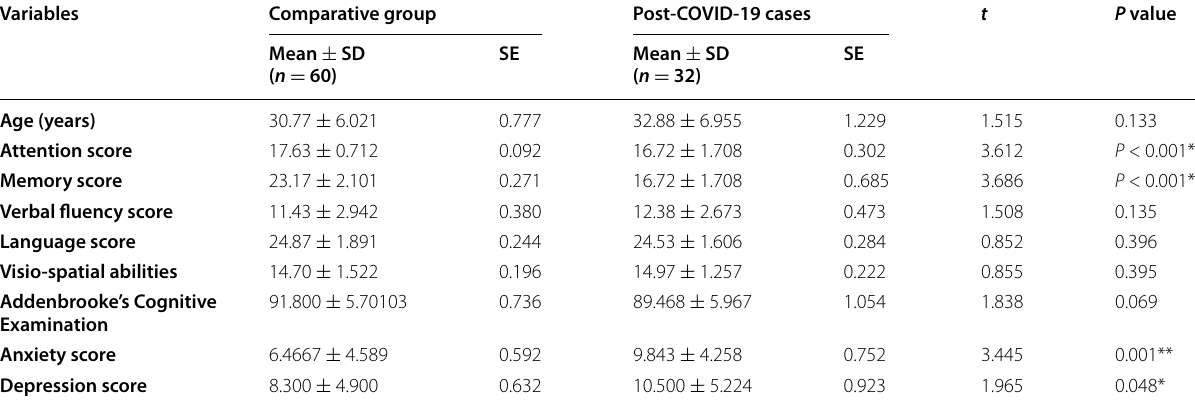
Table 2 A comparison between post‑COVID‑19 cases and a comparative group of healthcare workers according to their age and scores of attention, memory, verbal fluency, language, visio‑spatial abilities, Addenbrooke’s cognitive examination, anxiety, and